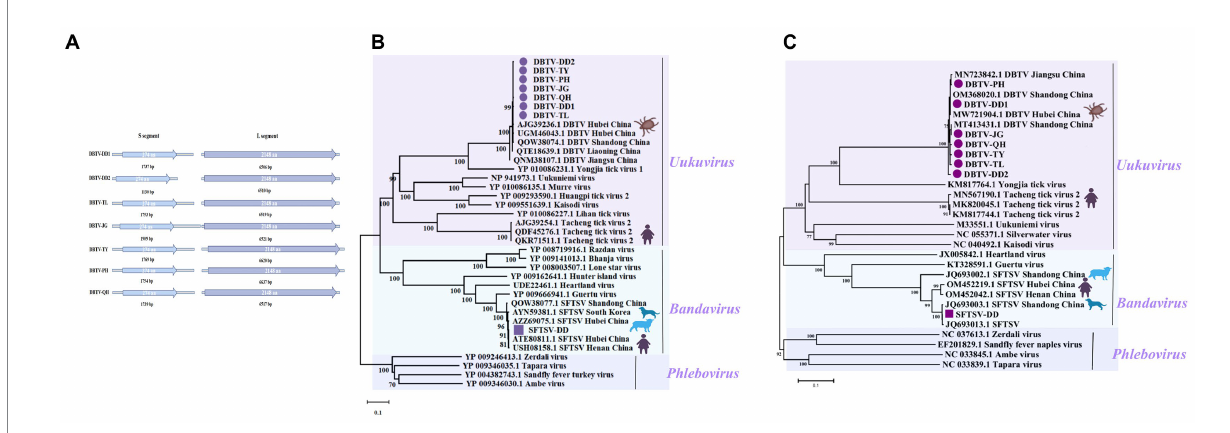
FIGURE 2 Genomic structure of the sequences of seven DBTVs and phylogenetic analysis of SFTSV-DD and DBTV. (A) The sequence structure of each DBTV, and the length of the encoded amino acids. (B) Phylogenetic trees of SFTSV-DD and 7 DBTVs based on RdRp sequence of members within Phenuiviridae . (C) Phylogenetic trees of SFTSV-DD and 7 DBTVs based on S segment of members within Phenuiviridae . Nodes with bootstrap values >70 are noted. Scale bars indicate substitutions per site. Animal icons represent host species. The circles marked in purple indicate the DBTV sequences obtained in this study. Those marked with purple squares depict SFTSV-DD sequences.